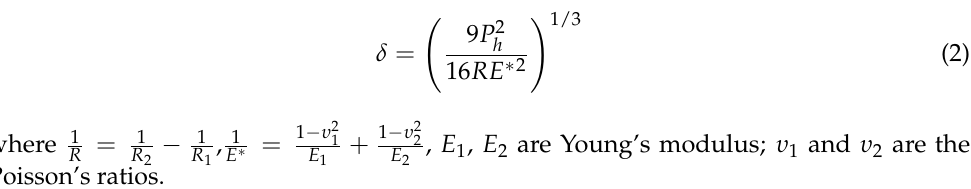
where 1 Poisson’s